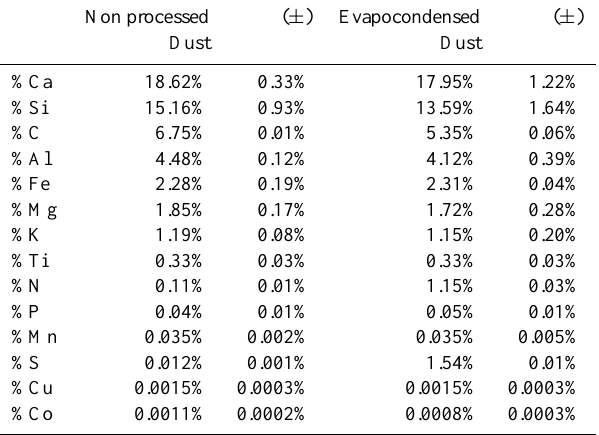
Table 2. Elemental composition of non-processed dust and evapoc- ondensed